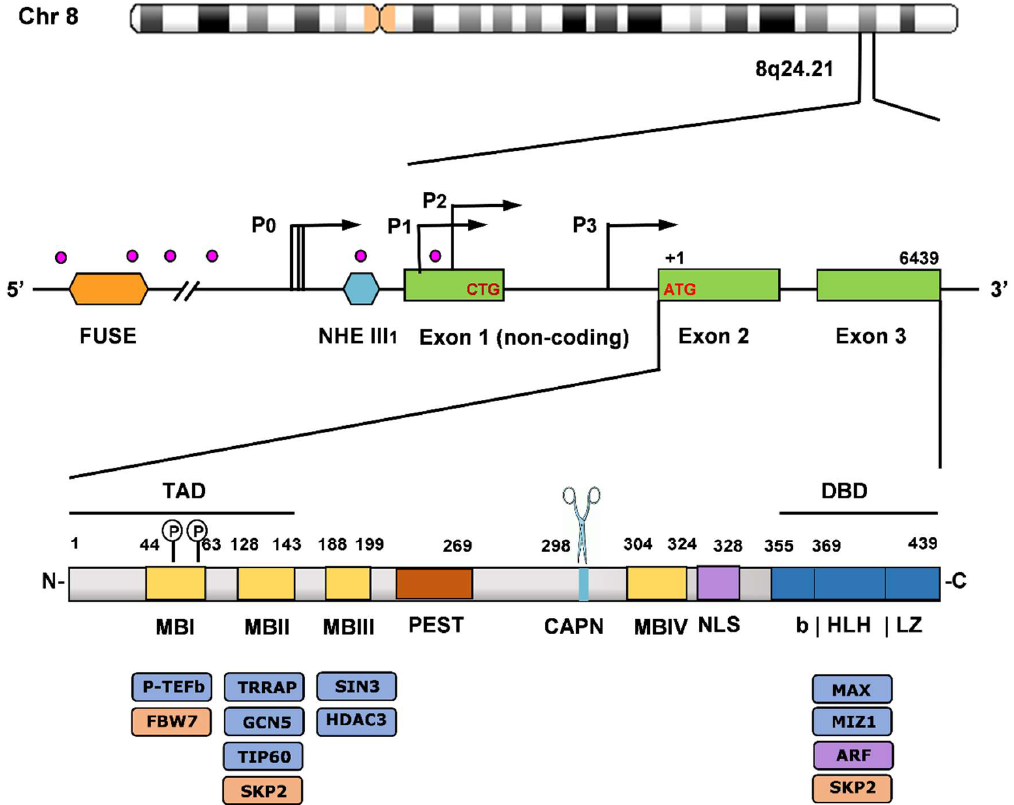
Figure 2. Structure of MYC gene and protein: functional domains and interactors. ( Top ) MYC locus. ( Middle ) MYC gene organization. ( Bottom ) Myc protein domains organization. A variety of proteins that regulate Myc activity and stability interact with these domains. The major Myc protein product, 439 amino acids long, is shown. Not drawn to scale. See text for details.